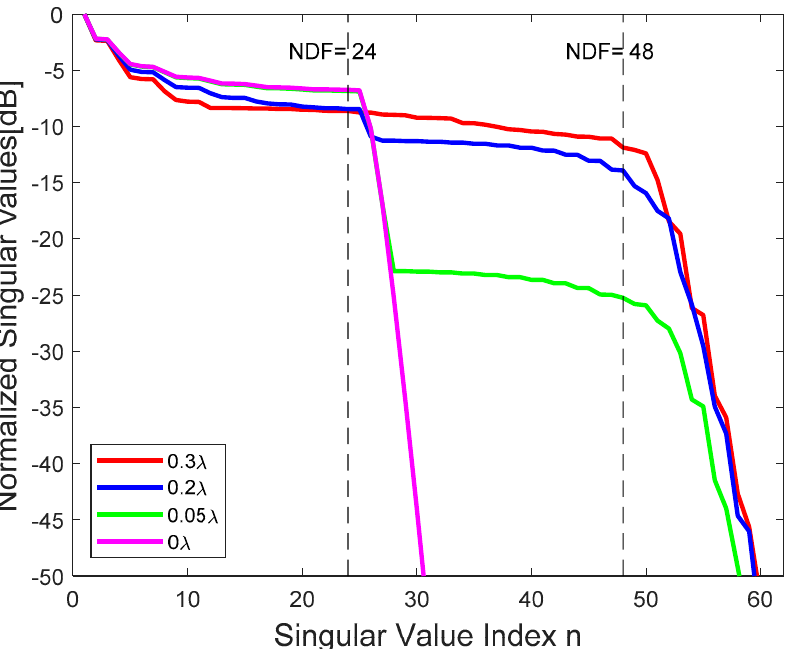
Figure 7. Normalized singular values of Equation (26) at different 𝑑 distances between the strips.